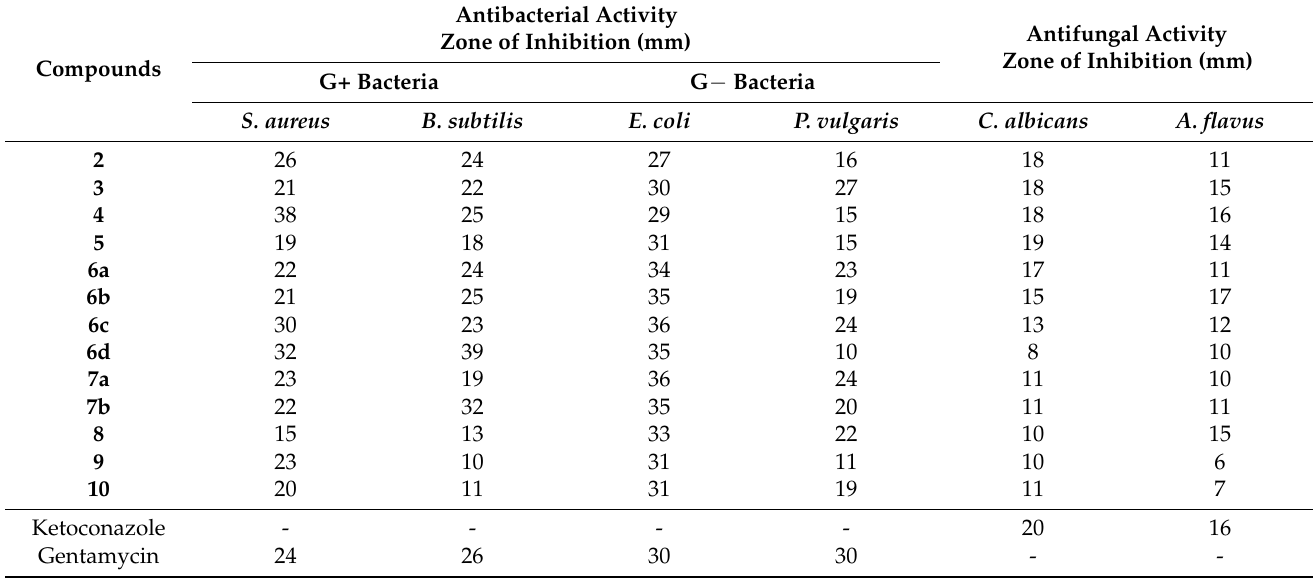
Table 1. Antimicrobial activities of piperazines 2 – 10